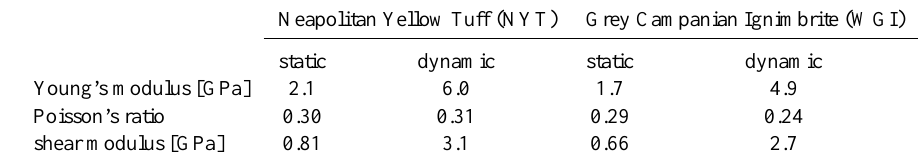
Table 6. The static and dynamic elastic moduli of NYT and WGI measured under an effective pressure of